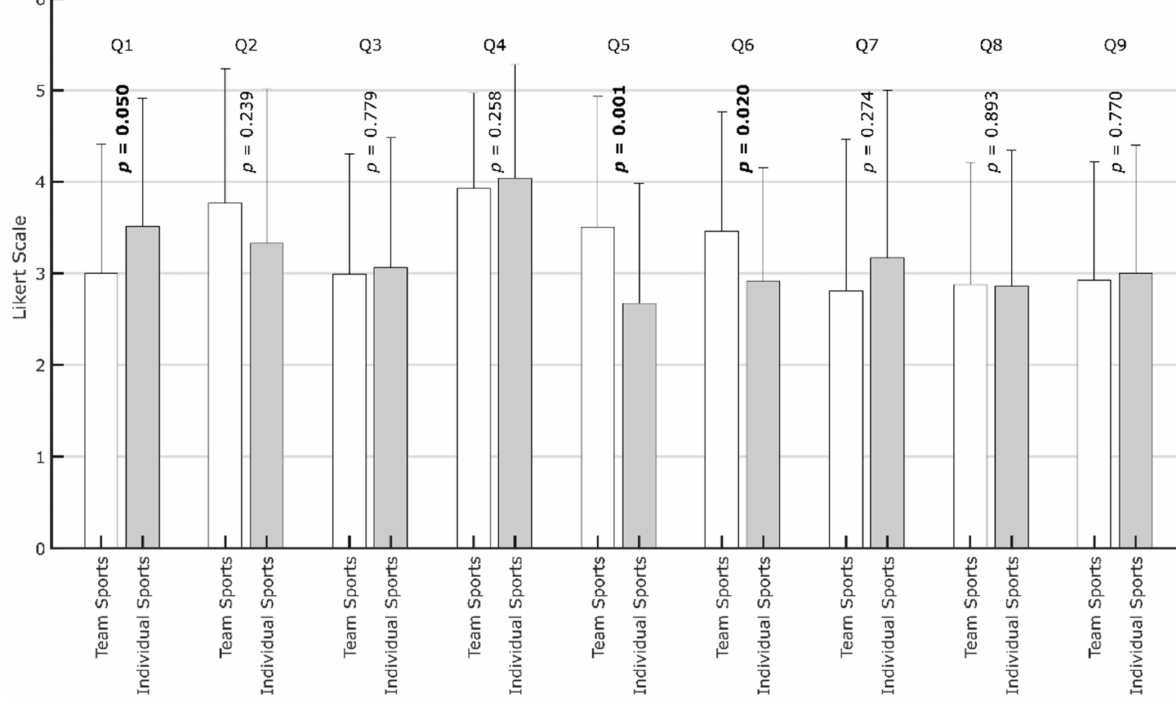
Figure 7. Diagram with means and standard deviations for the respective questions (Q1–Q9). The p -values for the tests of differences between participants who preferred team sports and those who preferred individual sports are plotted vertically. Bold font indicates a statistically significant ( p < 0.05) difference in the response between participants with an affinity towards team sports compared to participants with an affinity towards individual